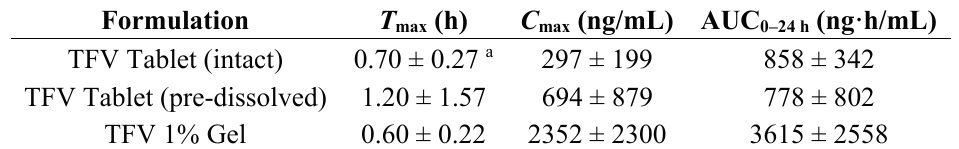
Table 2. TFV plasma pharmacokinetic (PK) parameters following a single dose intravaginal administration of 10 mg TFV tablets, intact versus predissolved (10 mg/mL), and 1 mL TFV 1% gel (Study